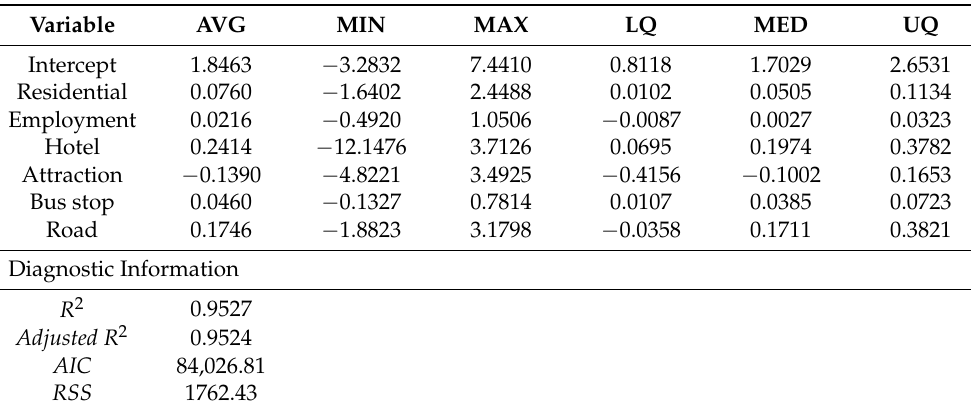
Table 5. Estimation of the GTWR